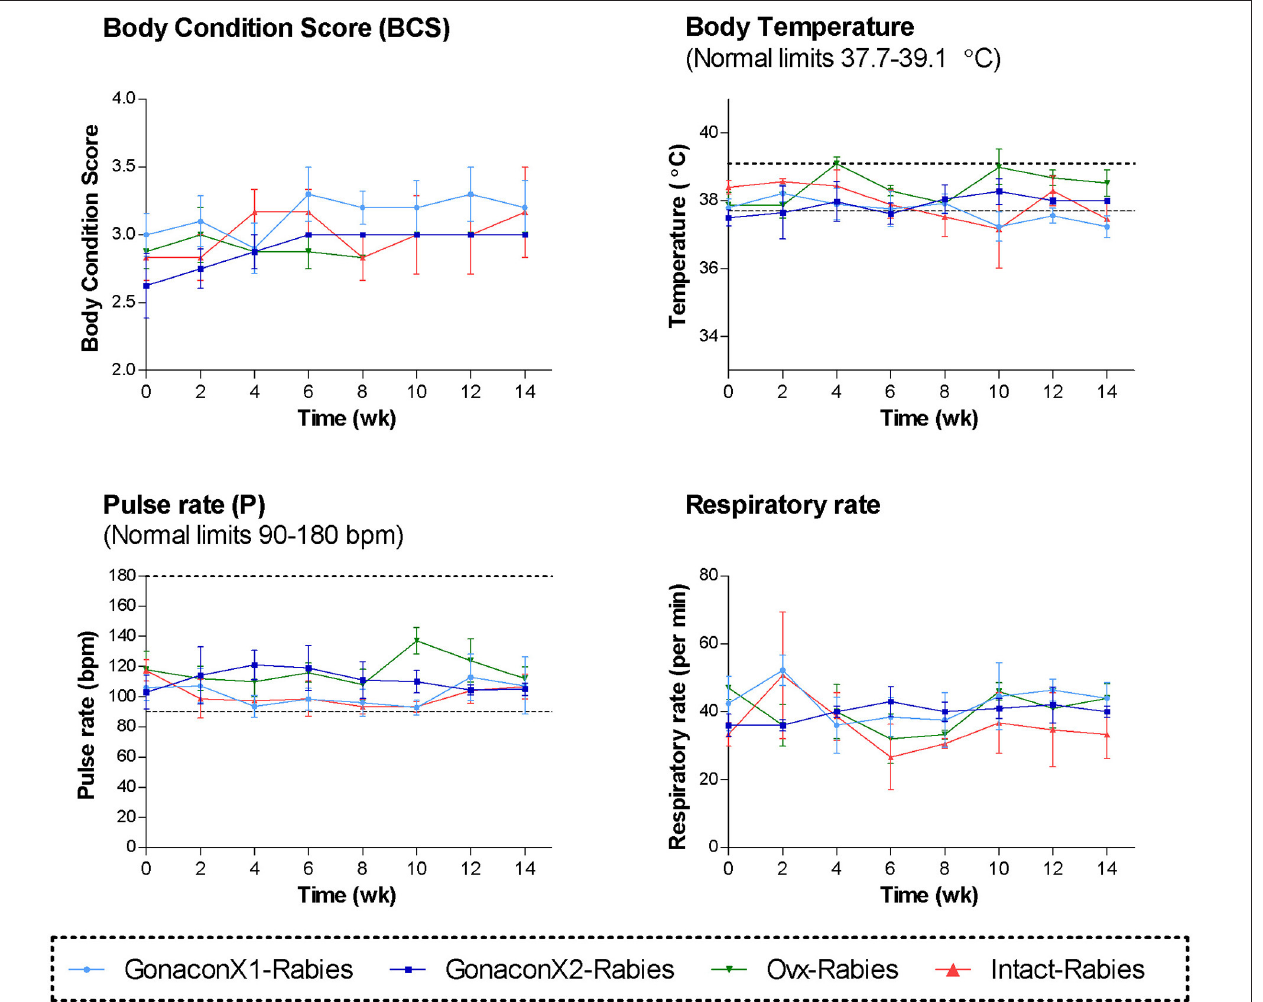
FIGURE 1 | Body condition score and the vital signs of cats in the research groups. Mean ± SEM of temperature, pulse, respiratory rate, and body condition score are presented for each group: GonaconX1-Rabies: cats vaccinated with both Gonacon and Rabies ( n = 5); GonaconX2-Rabies: cats vaccinated twice with Gonacon (3 weeks apart) and with rabies ( n = 4); OVx-Rabies: cats ovariohysterectomized and vaccinated with rabies ( n = 4); Intact-Rabies: cats vaccinated against rabies and remained intact ( n = 3). Parameters were collected every 2 weeks for a total of 14 weeks, while cats were under heavy sedation. Dotted lines indicate normal limits.